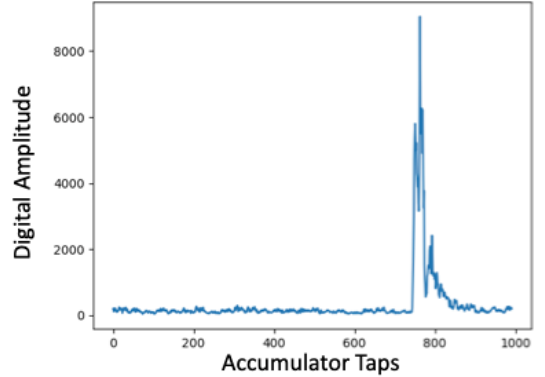
Figure 14. UWB Channel Impulse Response Window captured within the Forrest Room. The accumulator window captured several high magnitude peaks, including one just before the highest peak. These results indicate additional reflections within the space compared to the gym translating into ranging errors and reduced localization accuracy.